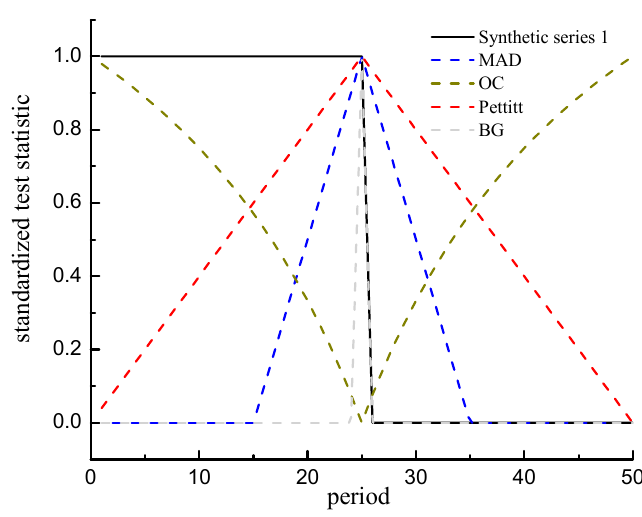
Figure 3. Detection results of different methods on single mutation point series without errors.